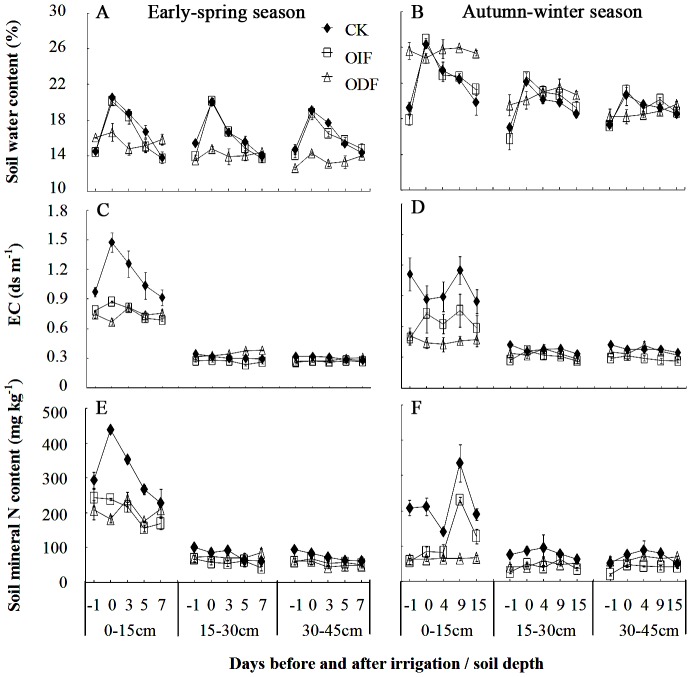
Effects of conventional interval fertigation (CK), optimal interval fertigation (OIF) and optimal daily fertigation (ODF) on changes of soil water content (A and B), EC value (C and D) and mineral N content (E and F) in the early-spring (ES) and autumn-winter (AW) seasons.The numbers on the abscissa represent the days before (negative value), during (zero) and after (positive value) irrigation. Bars represent standard errors.